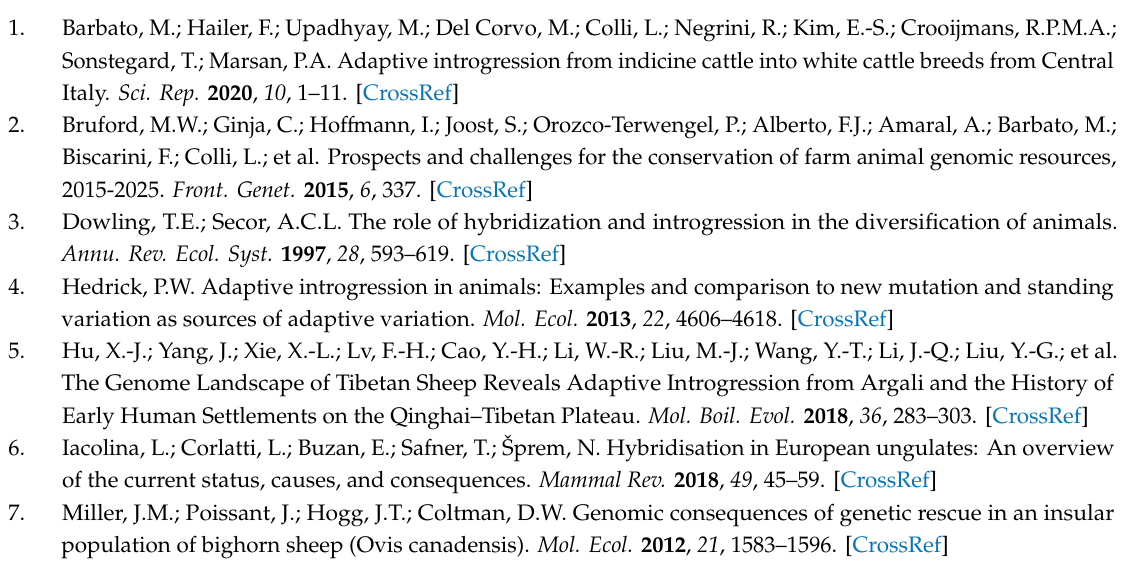
Figure S1: Unsupervised Admixture analysis for K = 2 evaluated on the full set of reference populations (SAR and MSar). Figure S2: Plot of PC1 loadings, squared and ordered. Red dots represent SNPs selected. Figure S3: For each one of the 20 subsequent iterations is shown the consensus number of SNPs “confirmed important” in all the performed iterations. Figure S4: plot of the Pearson correlation values density distribution of random panels test. The green line represents the correlation value obtained for the GW3 panel. Figure S5: distribution of SNPs per chromosome in panel CH1.Figure S6: Principal Components Analysis (PC1 vs PC2) analysis and density distribution of mouflon (MSar), hybrid (HYB), and domestic sheep (SAR) populations. The gradient legend on the right side of the plot shows the transition gradient from sheep to mouflon genetic components. The analysis was performed using panel CH1 and CH2. Figure S7: Principal Components Analysis (PC1 vs PC2) analysis and density distribution of mouflon (MSar), mouflon x domestic hybrid (MxS), and domestic sheep (SAR) populations. The gradient legend on the right side of the plot shows the transition gradient from sheep to mouflon genetic components. The analysis was with CH1 and CH2. Figure S8: supervised admixture K = 2 plot evaluated with full set on the HYB dataset. Table S1: distribution of SNPs per chromosome: for each AIMs panel is reported the exact number of SNPs per chromosome and the percentage related to